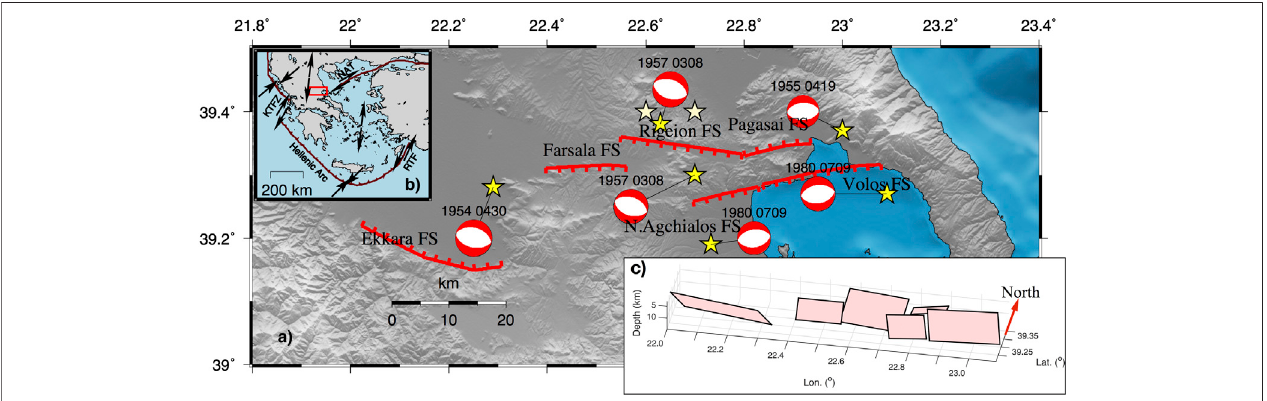
FIGURE 1 | (A) Strong earthquake ( M w ≥ 6.0) occurrence in the Southern Thessaly Fault Zone. Yellow stars depict the M w ≥ 6.0 events during the 20th century, whereas the white stars depict the historical ones during the 18th century. The six major segments of the Southern Thessaly Fault System are represented with the red solidlinesandtheirnamesarealsogiven.Focalmechanismsareplottedaslower-hemisphereequal-areaprojections.Theoccurrencedateofeacheventisannotatedon the top of focal spheres. (B) Main seismotectonic properties of the broader Aegean area along with the relative plate motions represented by the black arrows, eitherside ofthe active boundaries depicted by thethick red lines. Thestudy area isdenoted with arectangularred box. (C) Schematic 3D representation ofthe sixfault segments of the Southern Thessaly Fault Zone, modeled as rectangular planes for the current simulator application.